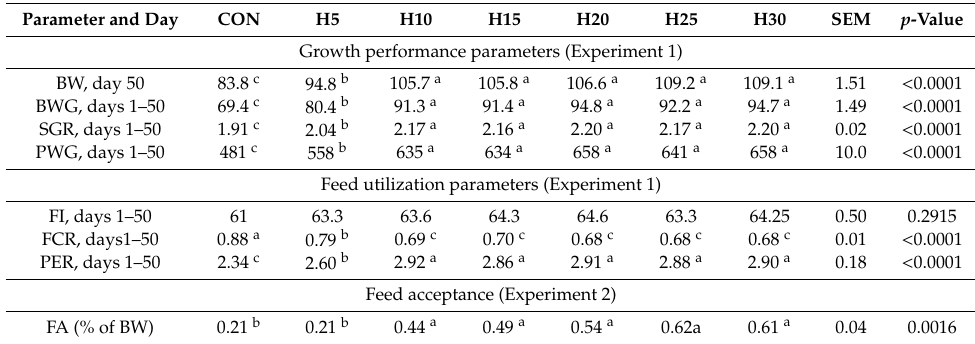
Table 5. Growth performance, feed utilization and acceptance of Siberian sturgeon fed experimental diets containing black soldier fly full-fat